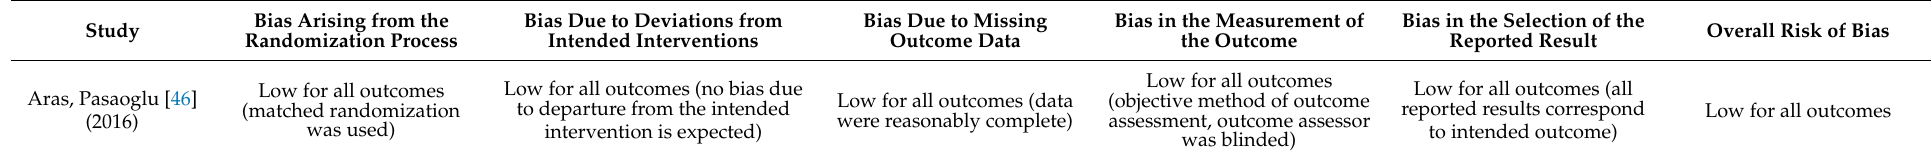
Table 2. Risk of bias assessment for Randomized clinical